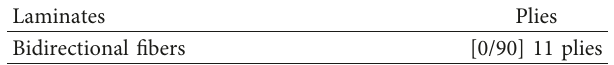
Table 4: Composite fiber orientation for basalt and E-glass. Laminates Plies Bidirectional fibers [0/90] 11